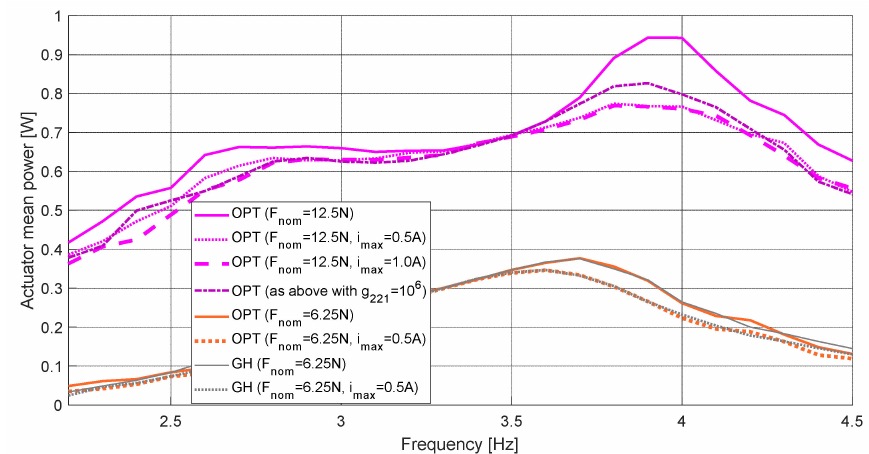
Figure 16. The mean actuator power frequency characteristics: OPT for different control parameter values vs. GH for F nom = 6.25